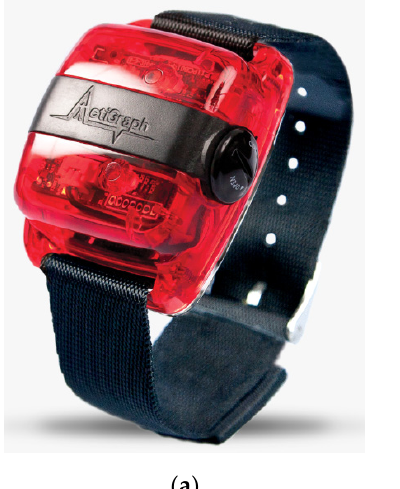
Figure 5. Bio-physiological characteristic information collection equipment MP150 ( a ) Biopac MP- 150 and EEG and ECG physiological signal amplifier host; ( b ) ACQKNOWLEDGE physiological signal capture record and analysis software, Schematic diagram of physiological signal measure- ment.